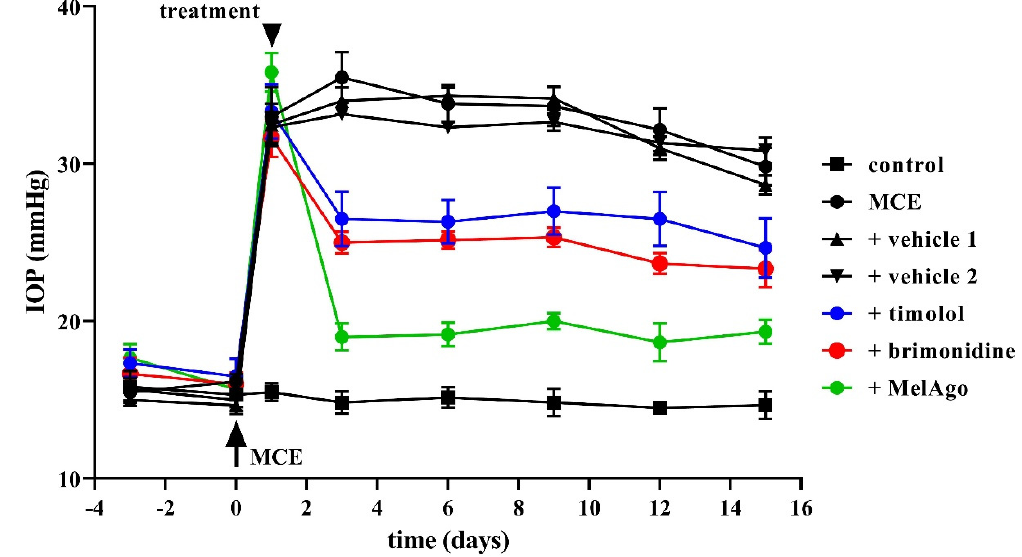
Figure 1. Effects of topical treatments on intraocular pressure (IOP) in a rat model of hypertensive glaucoma. Methylcellulose (MCE) injection in the anterior chamber at day 0 (arrow) significantly increased IOP ( p < 0.05; two-way ANOVA followed by Bonferroni’s multiple comparison post-test). Treatments started at day 1 (arrowhead). Vehicles (saline: vehicle 1, and nanomicellar formulation: vehicle 2) did not affect IOP, which was instead significantly reduced by timolol, brimonidine, or melatonin/agomelatine ( p < 0.05; two-way ANOVA followed by Bonferroni’s multiple comparison